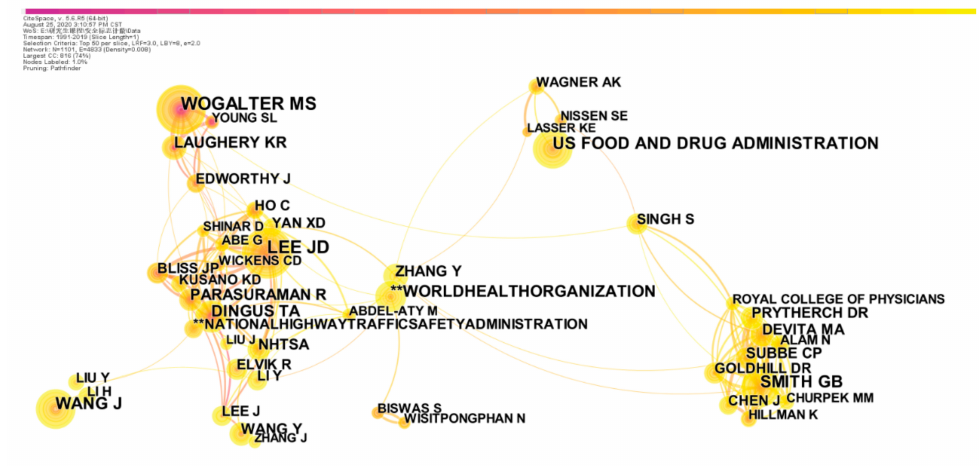
Figure 4. Author co-citation network of safety signs